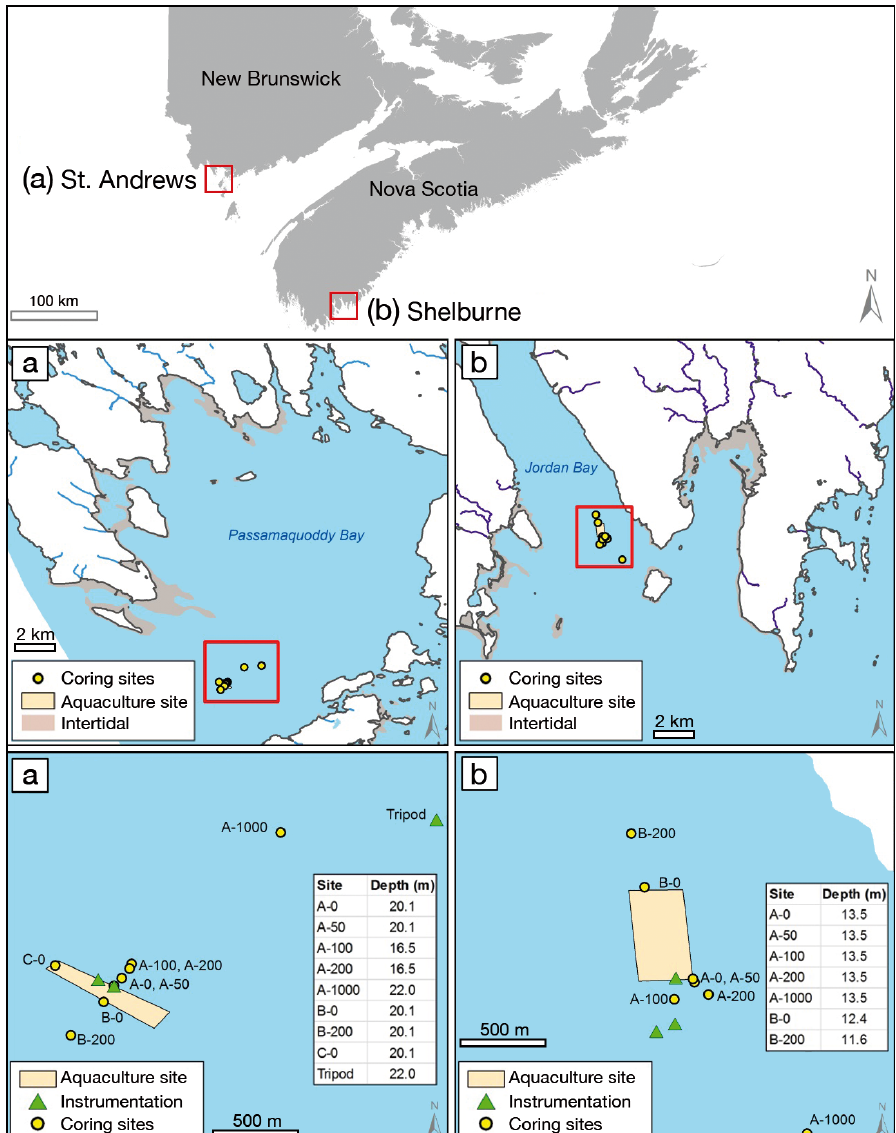
Fig. 1. The 2 study